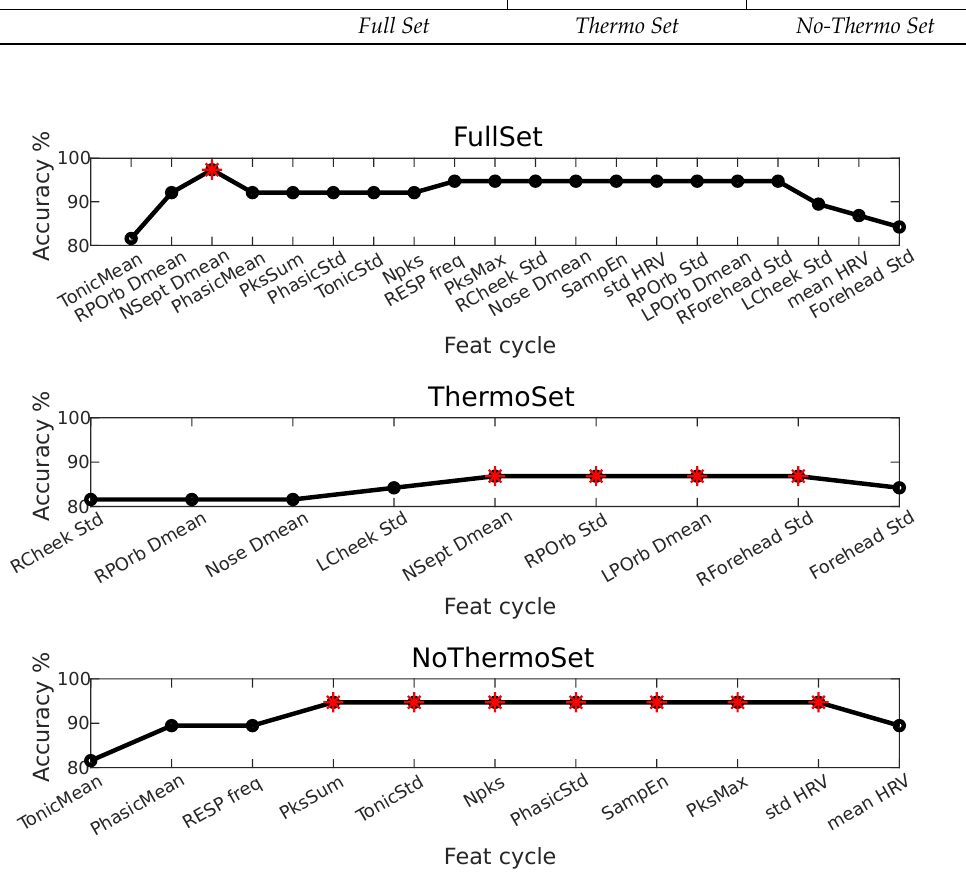
Figure 9. Accuracy trend of stress/non-stress recognition problem as a function of the selected features. The features are ranked according to the SVM-RFE criterion. Maximum accuracy is highlighted by red